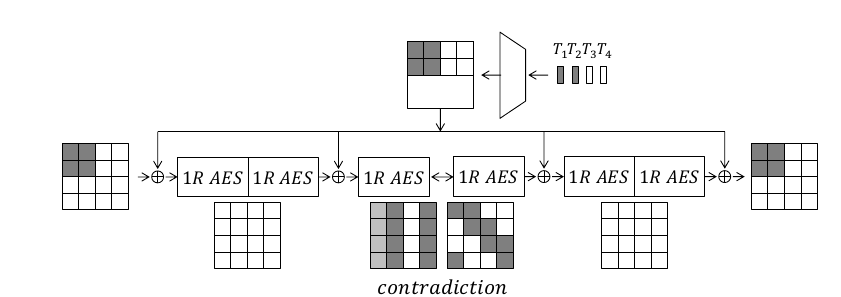
Figure 10: TweAES : 6-round Impossible Differential. The bytes filled with black, white, and gray have non-zero difference, zero difference, and arbitrary difference, respectively.